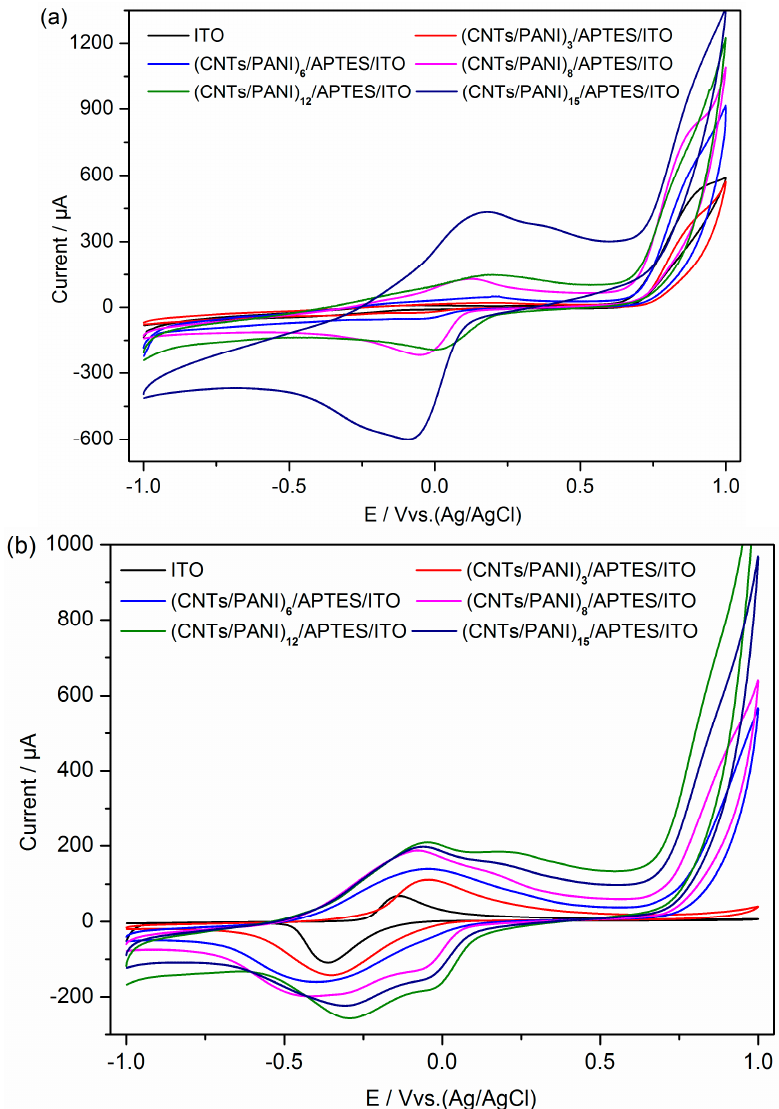
Figure 2. The cyclic voltammetry (CV) of ITO electrode and (CNTs/PANI) n /APTES/ITO electrode before inoculation ( a ) and at the end of batch tests ( b ) in bioelectrochemical cell with a scan rate of 10 mV/s. n = 3, 6, 8, 12 and 15.